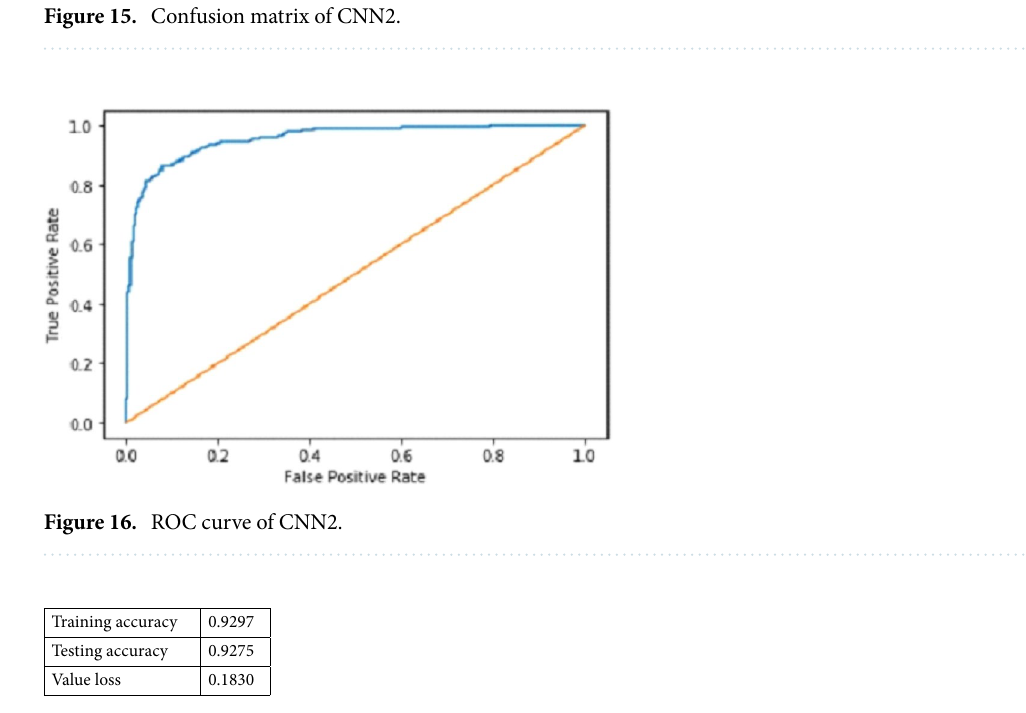
Table 3. Results of CNN